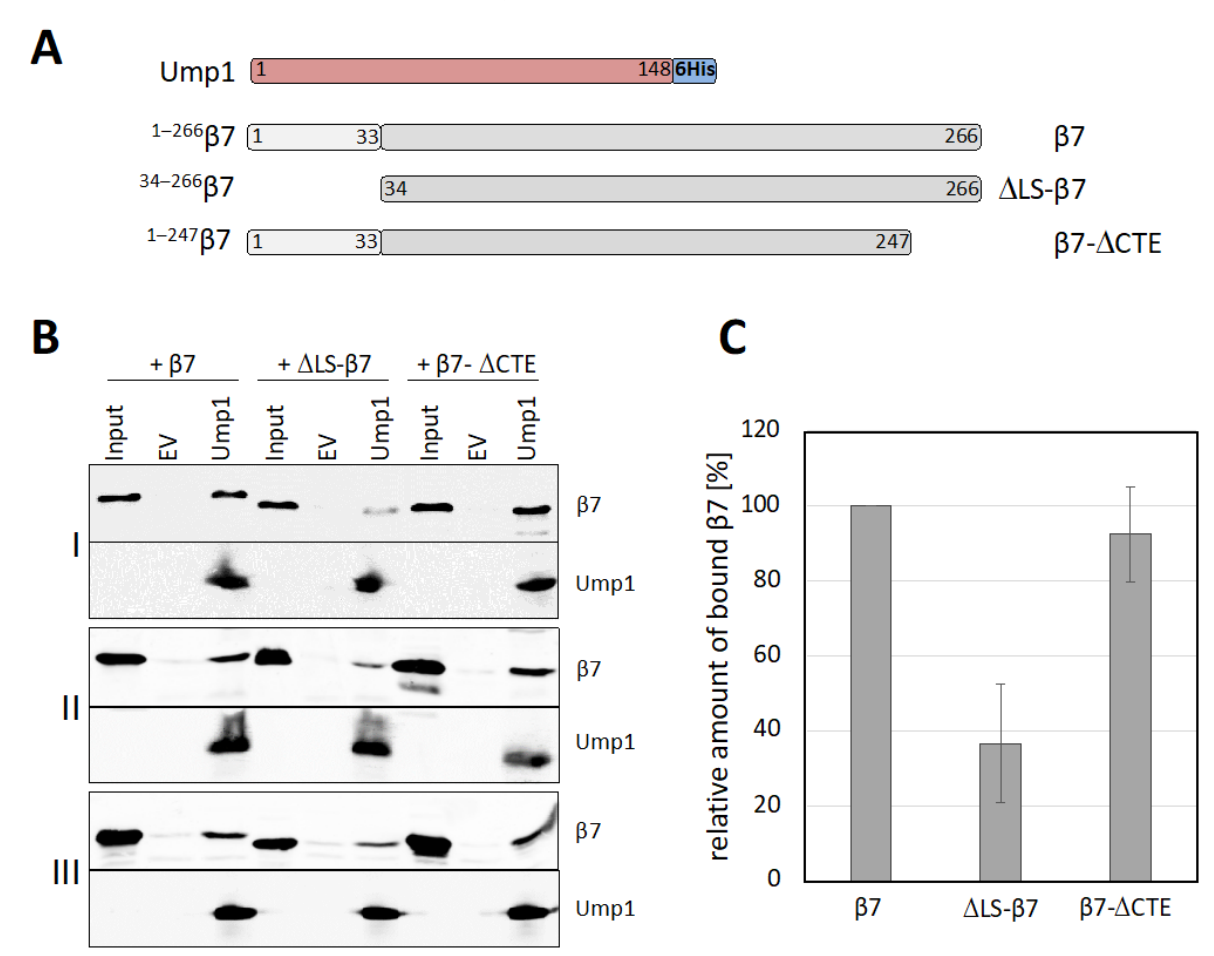
Figure 4. The propeptide of the β 7 precursor polypeptide promotes binding to Ump1. ( A ) Schematic representation of the constructs used in this experiment: Ump1 fused to 6His, and three distinct untagged β 7 versions (full-length, without leader sequence ( ∆ LS), without C-terminal extension ( ∆ CTE)). ( B ) Native extracts from E. coli cells transformed either with an empty vector control (EV) or with a plasmid expressing Ump1-6His were first incubated with Ni-NTA resin, which was then washed and further incubated with purified β 7 versions. Bound proteins were eluted with imidazole and analyzed by anti- β 7 and anti-Ump1 Western blotting. Shown are the results of three independent sets of experiments (I, II, and III). ( C ) Comparison of the binding efficiencies of tested β 7 variants and full-length Ump1. Quantitative evaluation of the signals shown in ( B ) was performed with the LI-COR infrared scanner. Signals of the β 7 variants eluted from Ump1-loaded resin were first set in relation to the input, of which 10% was loaded on the gel. Background β 7-EV signals were subtracted. The mean value for recovery of full-length β 7 was set to 100%, and the signals for the truncated variants were related to it. Error bars represent standard deviation of the mean ( n =